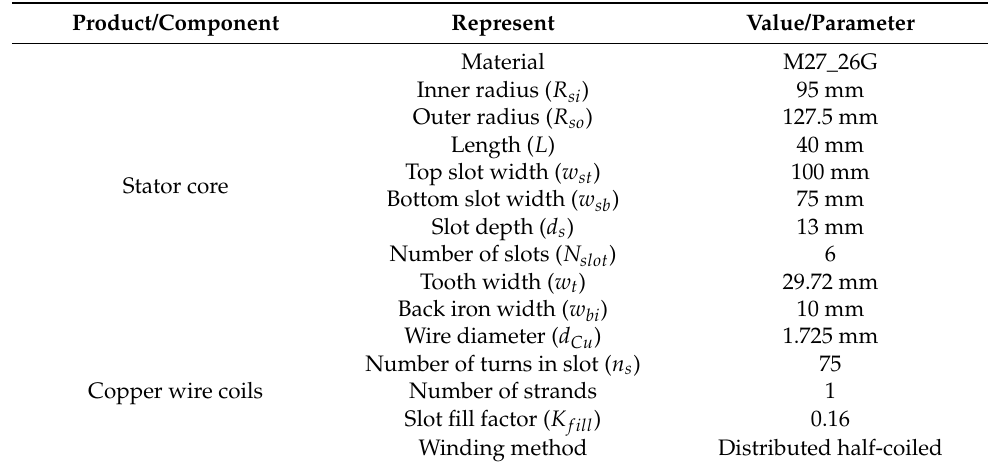
Table 6. Electromagnetic driver‘s components design